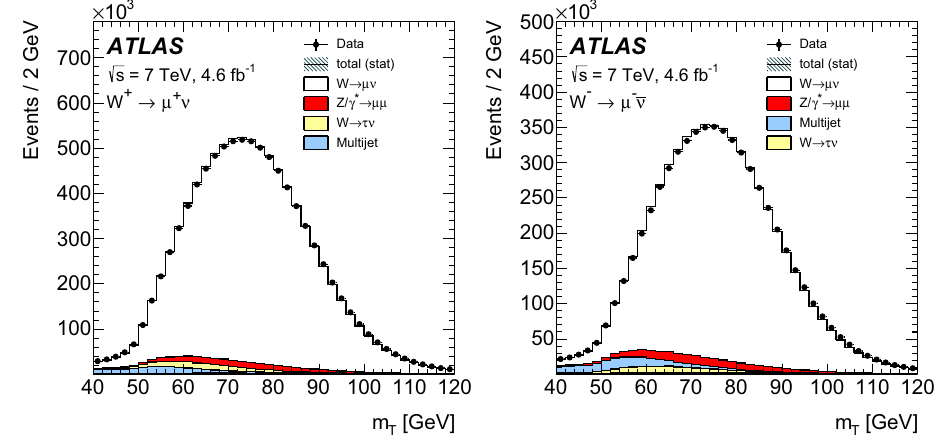
m40 [GeV] T Fig. 13 The transverse mass distribution for W + → μ + ν candidates of multijet events. The sum of all expected background and signal con- tributions is shown as a solid line with a hashed band detailing the ( left ) and W − → μ − ¯ ν candidates ( right ). The simulated samples are normalized to the data luminosity. The multijet background shape is statistical uncertainty and labelled “total (stat)”. The legend lists only background sources with a visible taken from a data control sample and normalized to the estimated yield